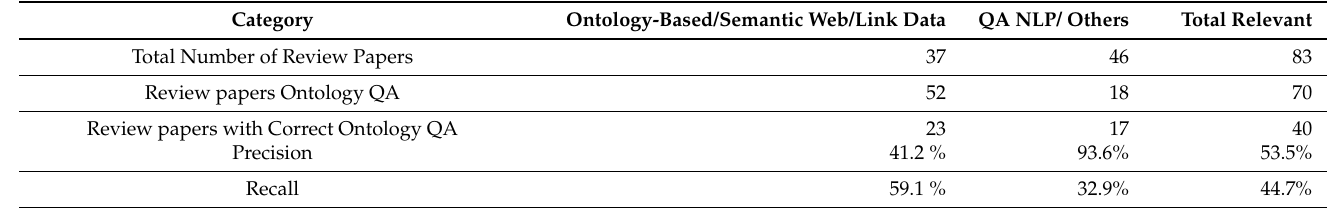
Table 2. Evaluation